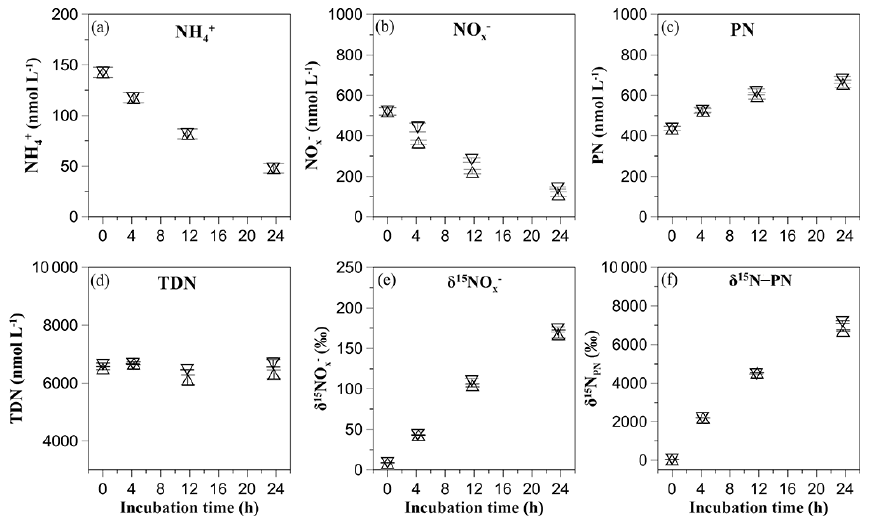
Figure 2. The observational data in the low-nutrient case for (a) [NH + The regular and inverse open triangles represent the paralleled samples and the analytical errors are